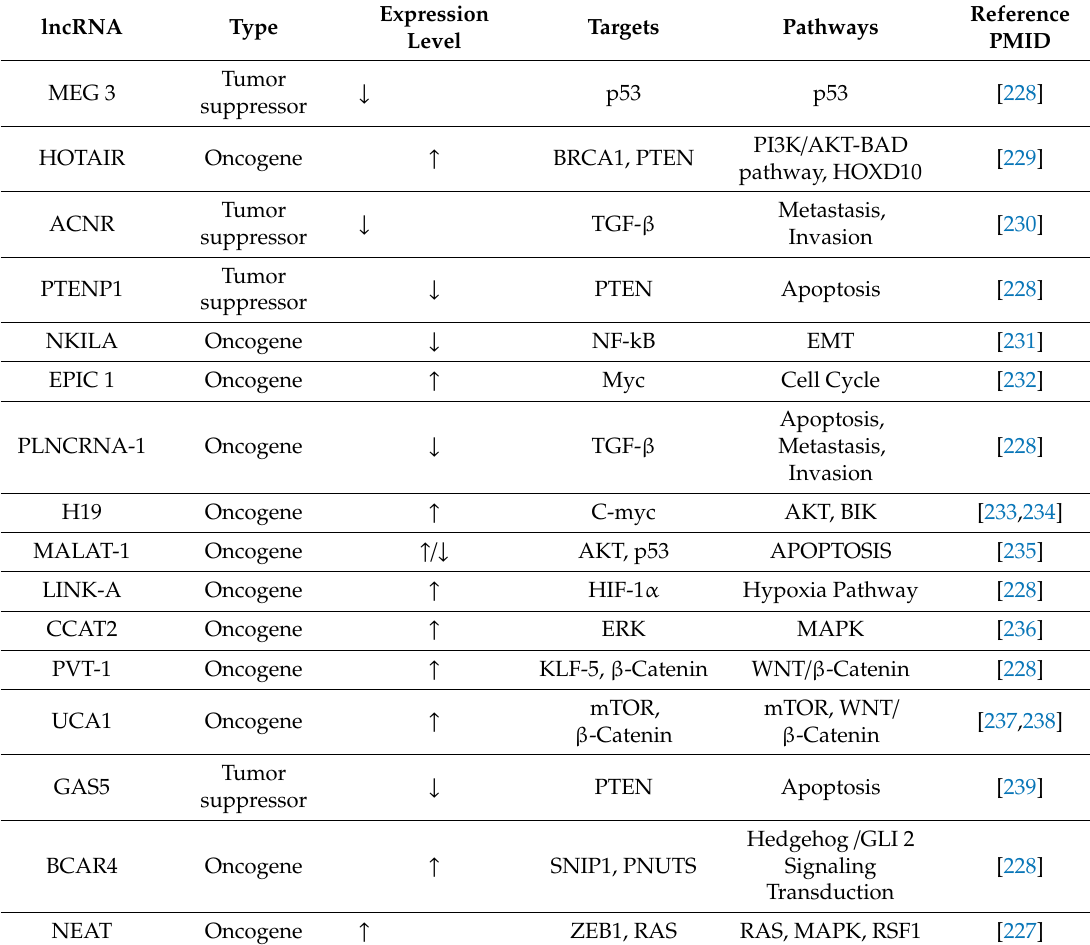
Table2. RoleoflncRNAsactingaseithertumorsuppressor /